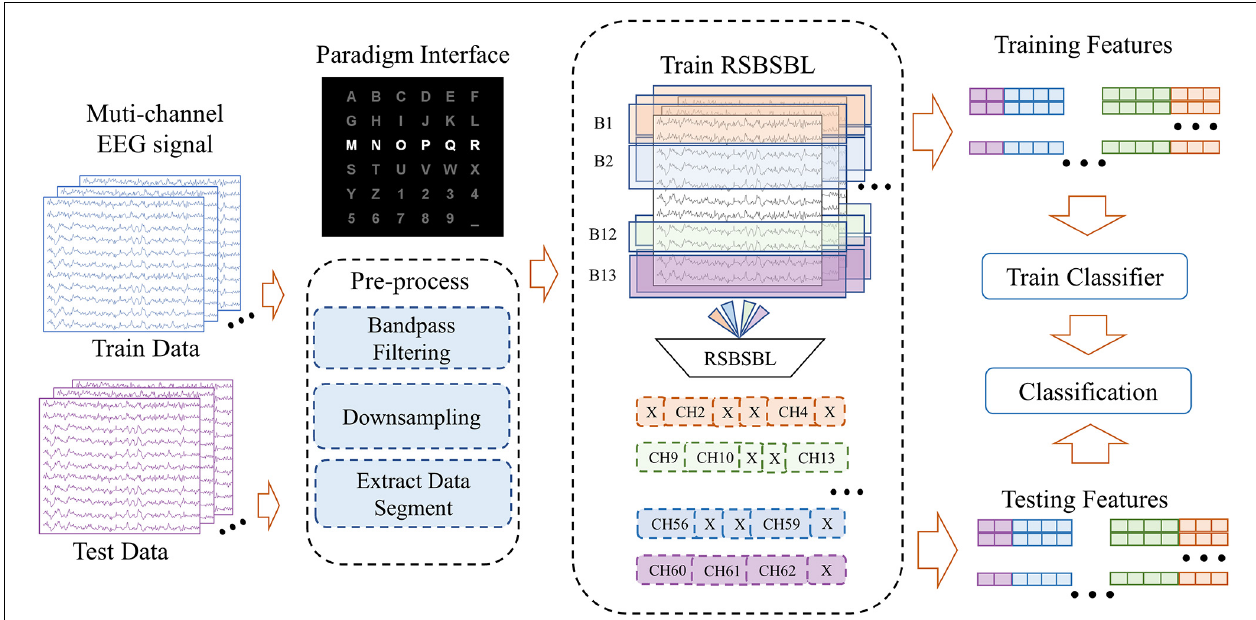
FIGURE 3 | Diagram of the data processing framework, including pre-processing, channel selection, and classification. Using the block sparsity property of RSBSBL, we do pruning on the eligible channels by fitting the training data and